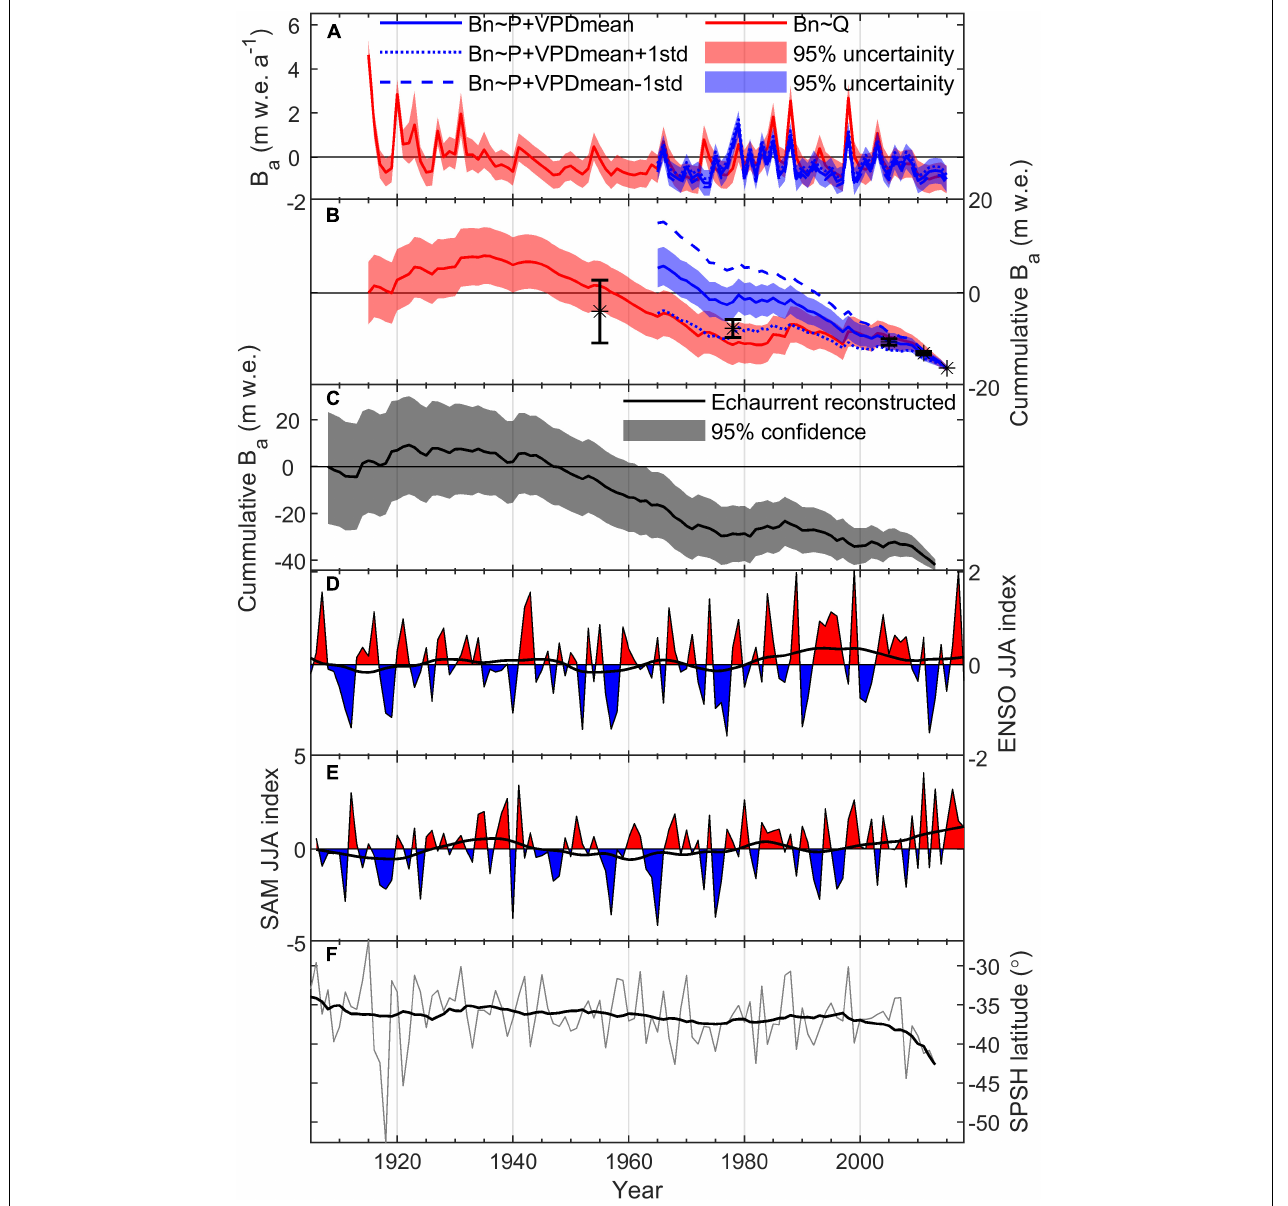
FIGURE 11 | Reconstructed mass balance of Guanaco Glacier. (A) Annual mass balance reconstructed from precipitation and vapor pressure deficit (VPD) (blue) and streamflow (red). Thick blue curve: model with mean VPD at La Frontera (1999–2015); upper dashed/lower dotted blue curves: models with mean ± one standard deviation from mean VPD. (B) Reconstructed cumulative mass balance of Guanaco Glacier based on precipitation and VPD ± std (blue) and composite streamflow (red). Cumulative geodetic (1955–2011) and glaciological (2011–2015) mass changes were computed backward from 2015 and shown as black asterisk with error bars. (C) Reconstructed mass balance of Echaurren Norte Glacier (33.58 ◦ S, 70.13 ◦ W) (Masiokas et al., 2016). (D) JJA Bivariate ENSO index with 21-year lowess curve (black trace); (E) Southern Annular Mode (SAM) index, with 21-year lowess curve (black); (F) Annual latitudinal position of the South Pacific Subtropical High (SPSH) 1020 isobar, with 21-year lowess curve